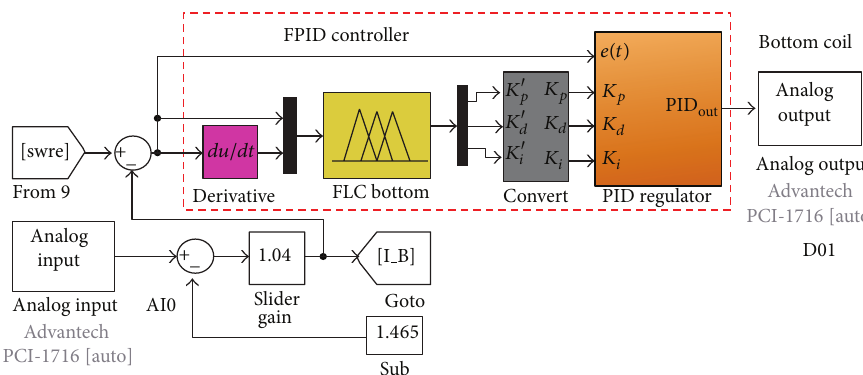
Figure 17: Model of real time window target for current-control